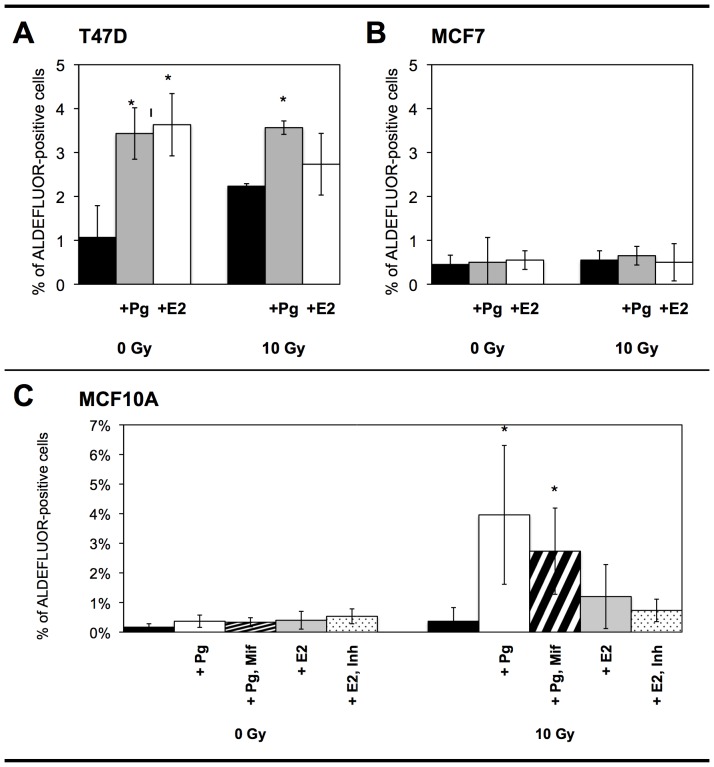
Proportion of CSCs after irradiation and steroid hormone treatment.The percentages of ALDH+ T47D (A), MCF7 (B) and MCF10A (C) cells were evaluated by flow cytometry three days after irradiation. Hormonal treatment was performed two days before irradiation and every day afterwards. Pg: progesterone, Mif: mifespristone, E2: estrogen, Inh: PD173074. Results are representative of at least three independent experiments. Error bars represent standard deviation. Asterisks denote significant differences (t-test, *p<0.05, **p<0.01).